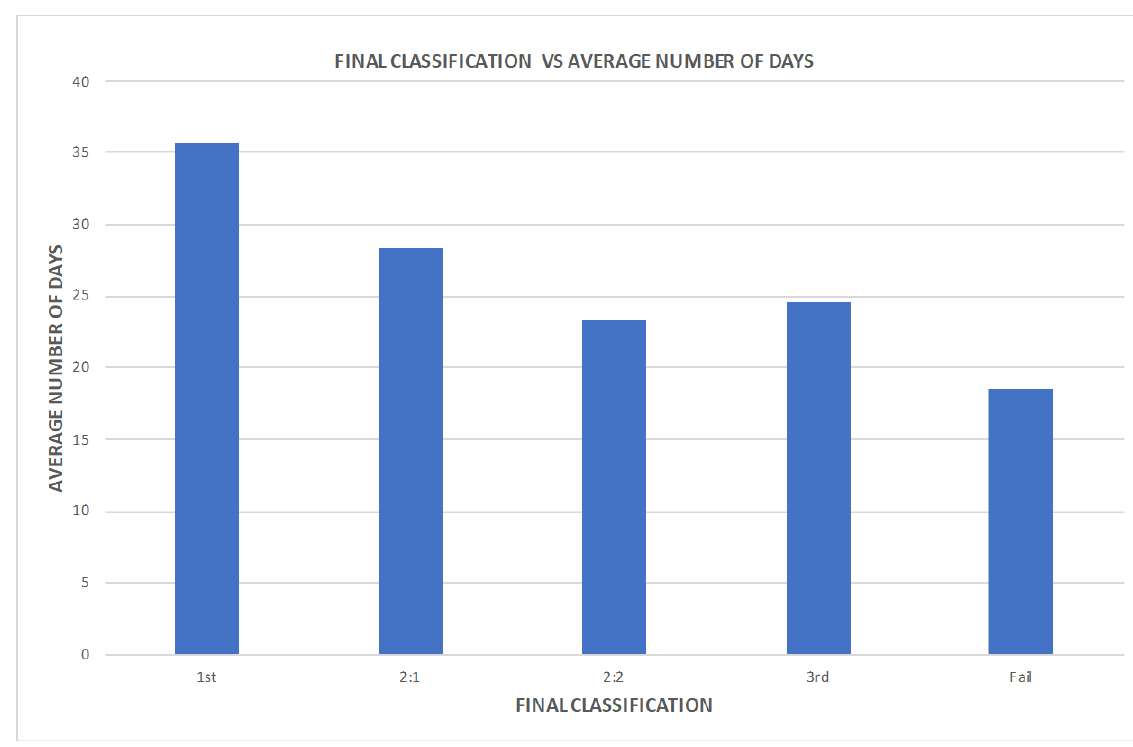
Figure 7 . Final Classification vs Number of Days on which material was